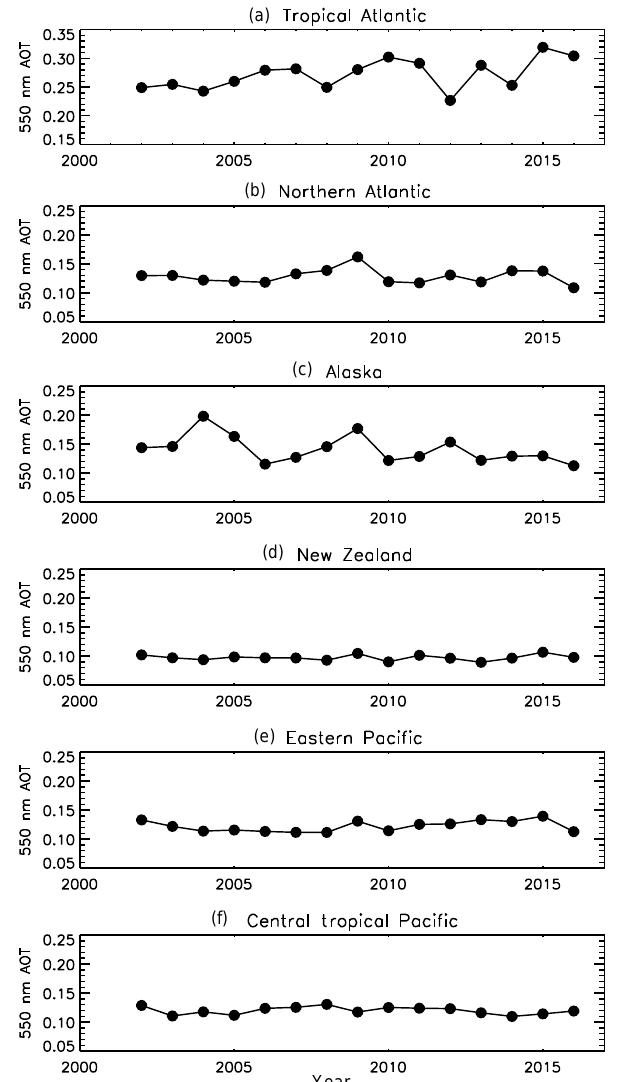
Figure 12. Time series of regionally averaged August MODIS 550nm AOT. Only values over oceans are included in the regional averages. The y -axis range for panel (a) differs from the other pan- els due to the higher AOT values in that region